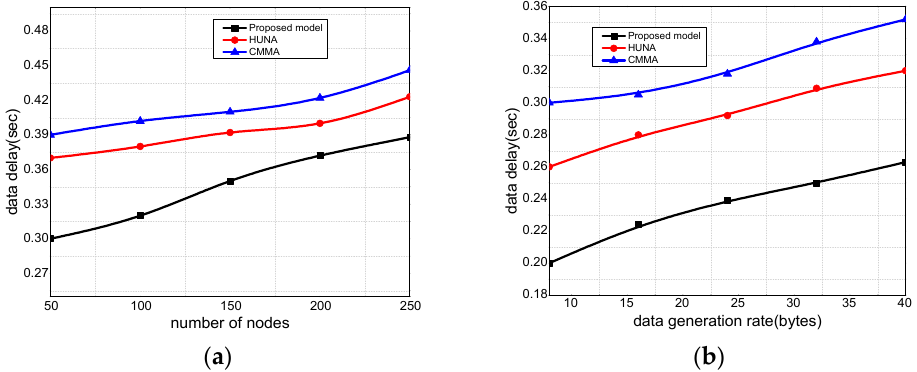
Figure 5. Performance of data delay with varying number of nodes ( a ) and packet generation rate ( b ).